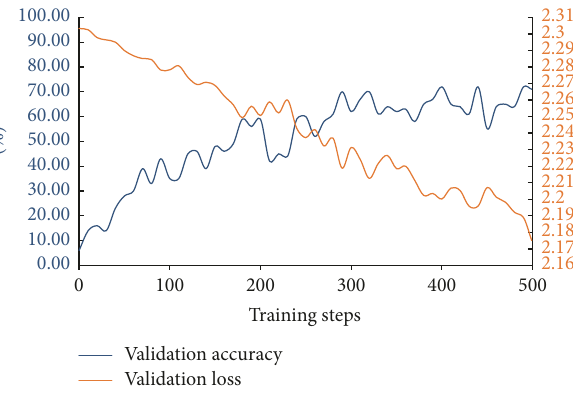
Figure 8: Validation accuracy and loss for 1st training.